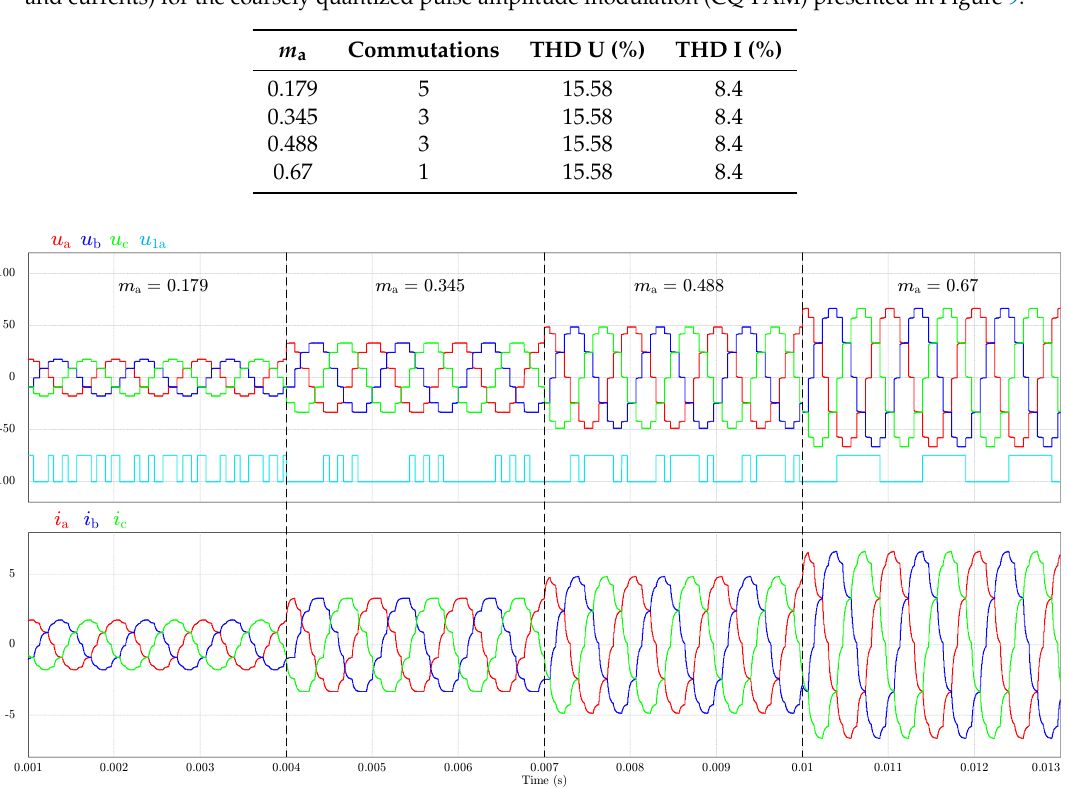
Figure 9. Output voltage and current waveforms of the 12-pulse modular VSI with CQ-PAM